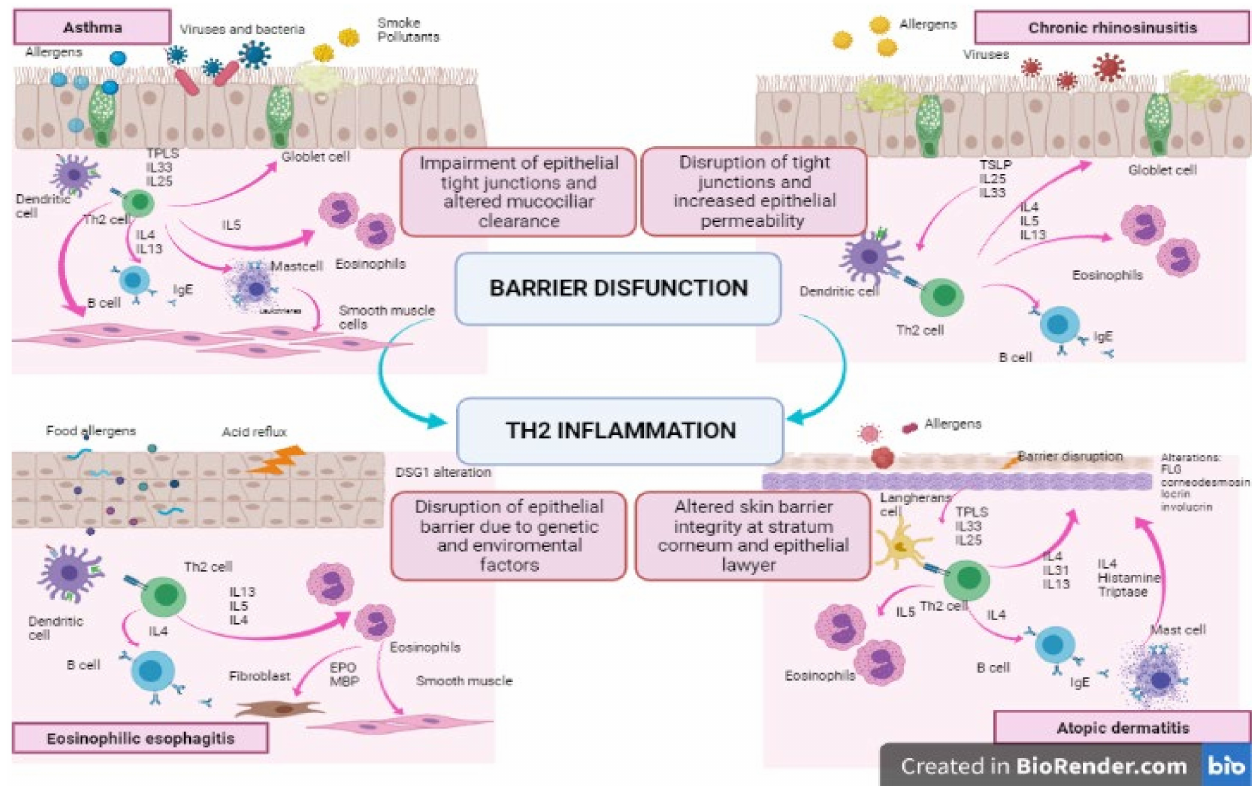
Figure 1. Barrier dysfunction and type 2 inflammatory response in asthma, CRSwNP, AD, and